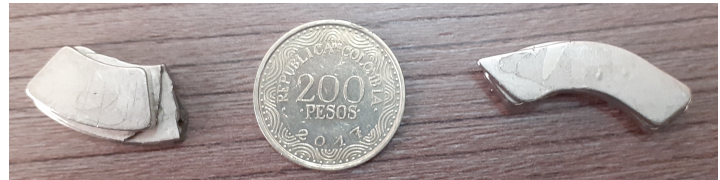
Figure 15. Elements used to simulate